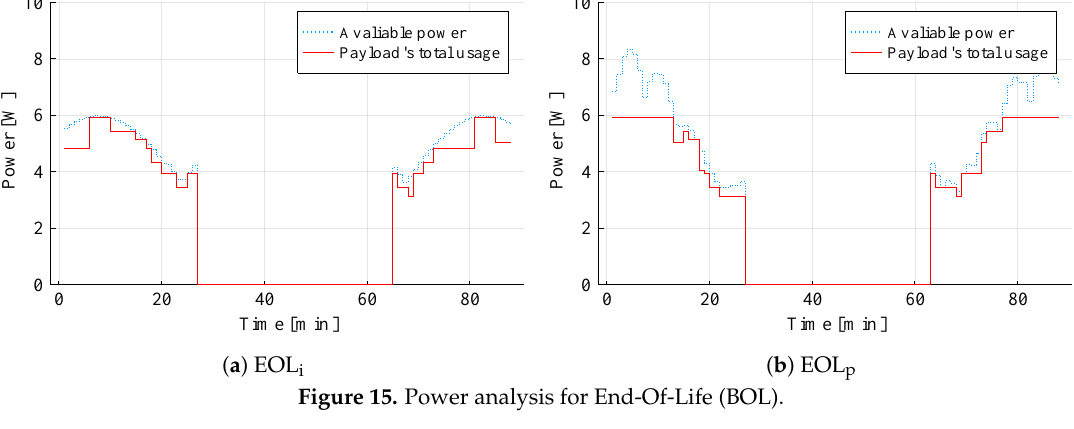
Figure 15. Power analysis for End-Of-Life (BOL).